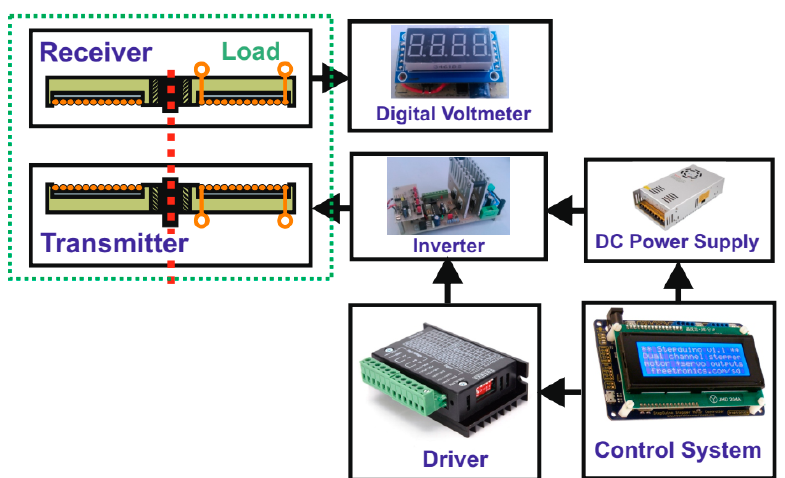
Figure 7. Block diagram of the experimental setup.